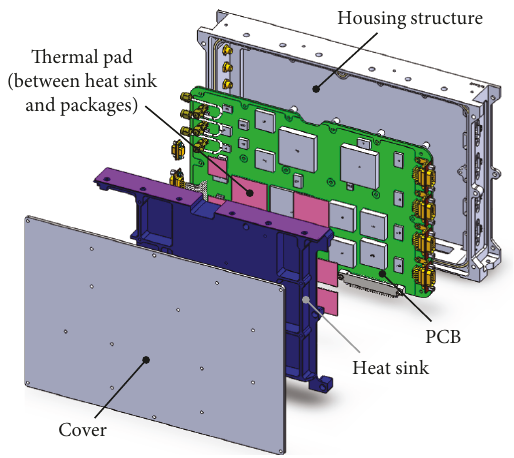
Figure 2: Example of thermal design for electronics using the thermal gap